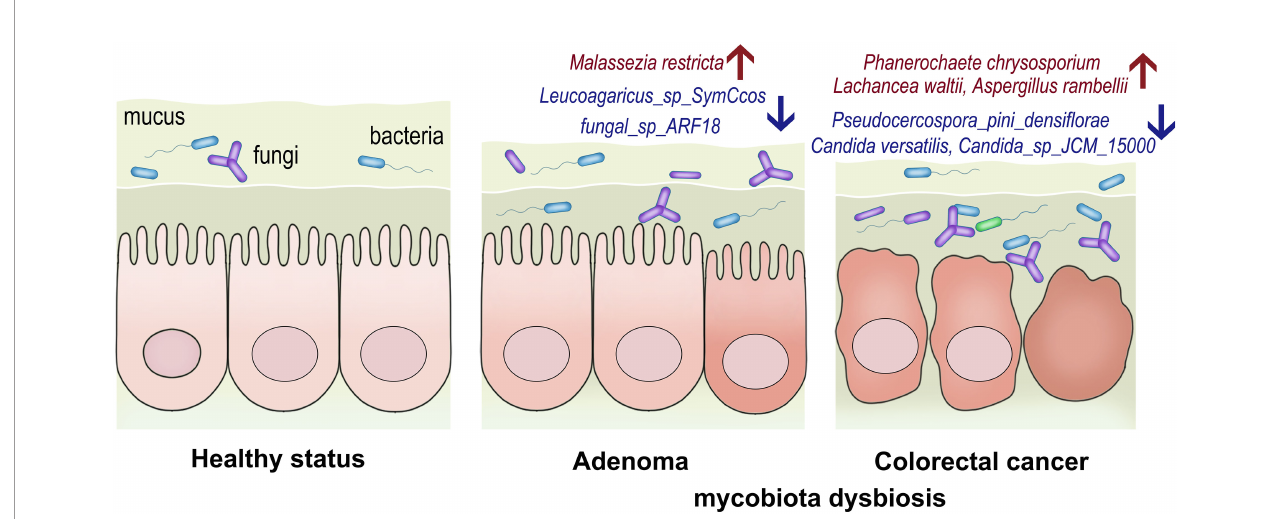
FIGURE 7 | The conceptual fi gure to demonstrate the alterations of gut mycobiota in adenoma and colorectal cancer. The relative abundances of Malassezia restricta increased, while Leucoagaricus_sp_SymCcos and fungal_sp_ARF18 signi fi cantly decreased in adenoma. Phanerochaete_chrysosporium , Lachancea_waltii , and Aspergillus_rambellii were the top 3 fungi that were signi fi cantly enriched in colorectal cancer, while Candida_versatilis , Pseudocercospora_pini_densi fl orae , and Candida_sp_JCM_15000 were dominant in the healthy